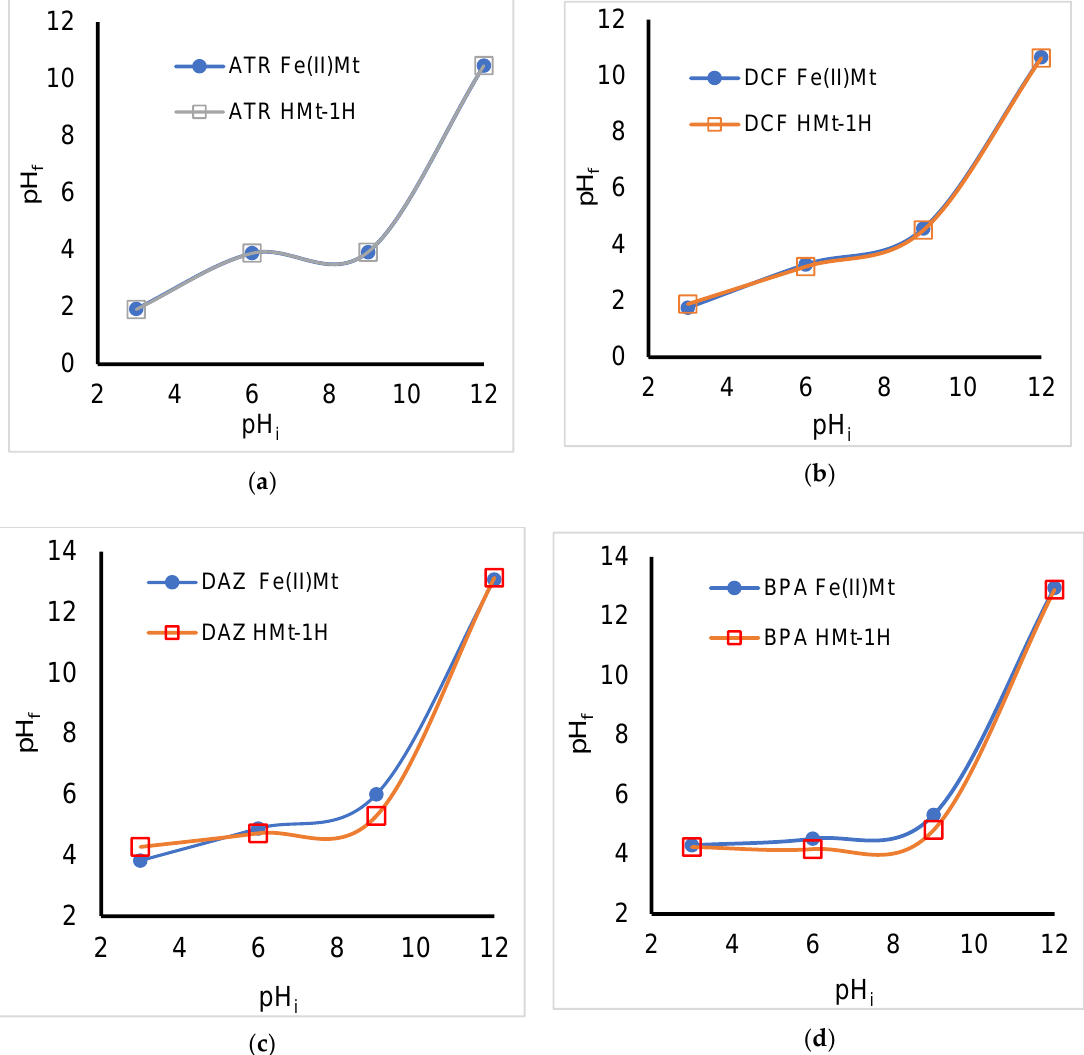
Figure 1. Final pH (pH final ) versus adjusted pH of the aqueous solutions of ATR ( a ), DCF ( b ), DAZ ( c ) and BPA ( d ) containing the clay suspensions.